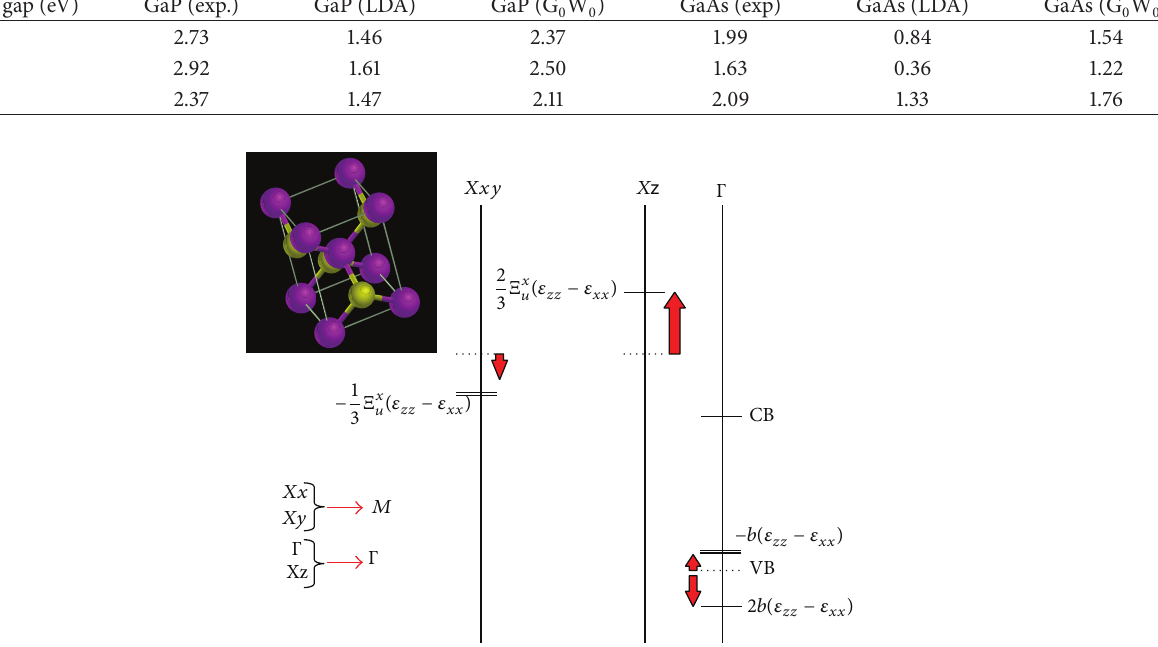
required to recover the right order for the X and L band-gaps Table 2: Electronic band-gap energies at 𝑇 = 0 K without SOC